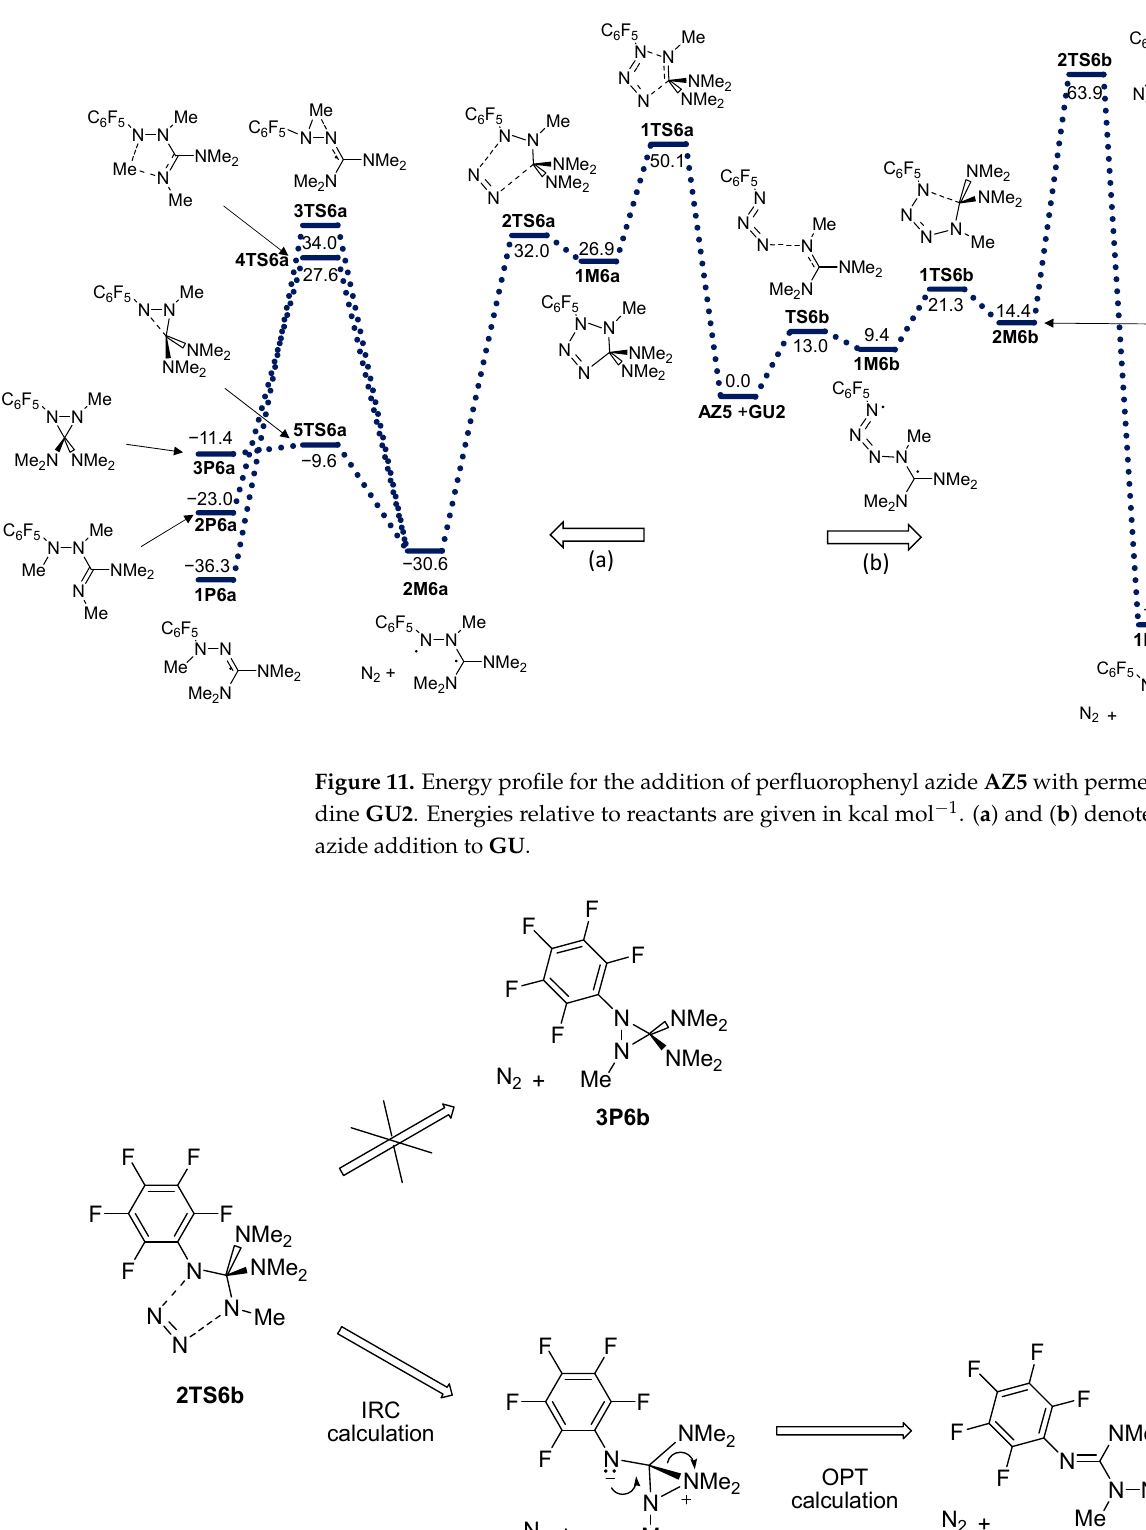
Figure 12. Schematic representation of the rearrangement of adducts from the addition of azide AZ5 to guanidine GU2 in the (b) direction.